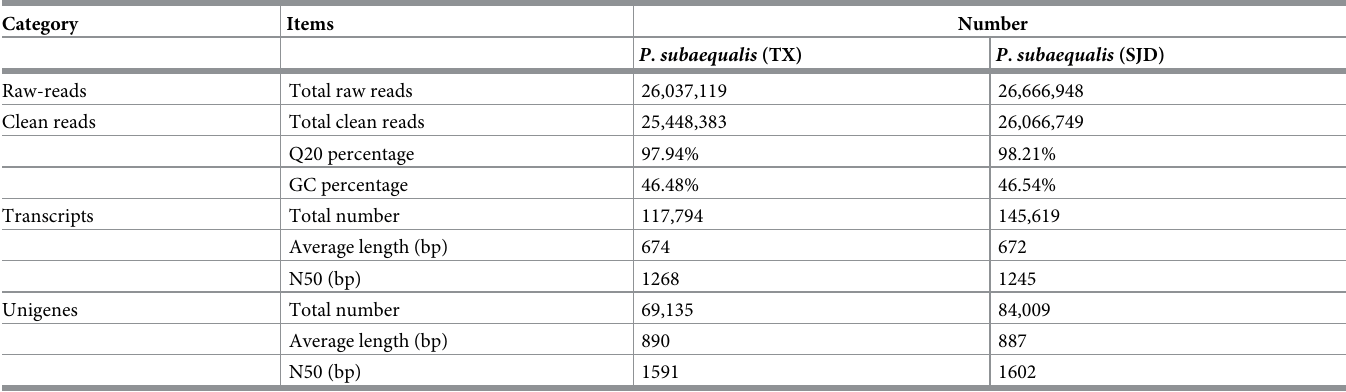
Table 1. Summary of the de novo assembly of two individuals of Parrotia subaequalis .